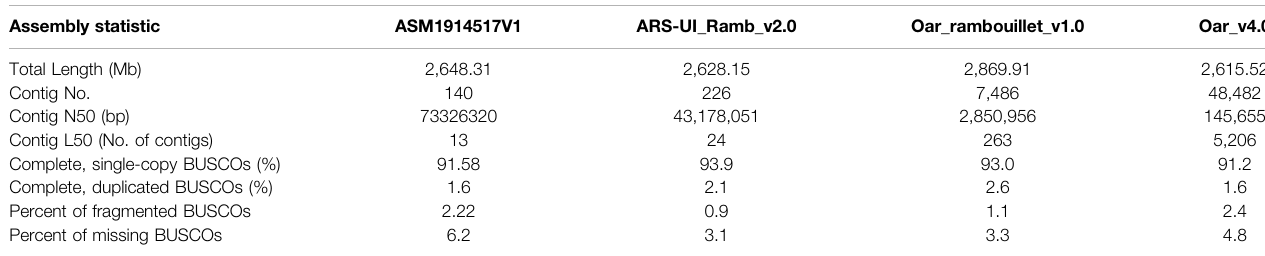
TABLE 2 | Assembly quality statistics comparison. Assembly